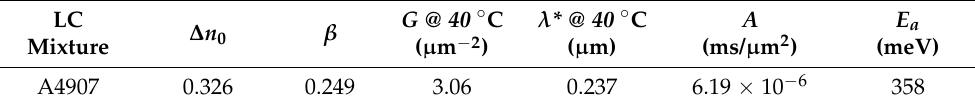
Table 2. Fitting parameters obtained through Equations